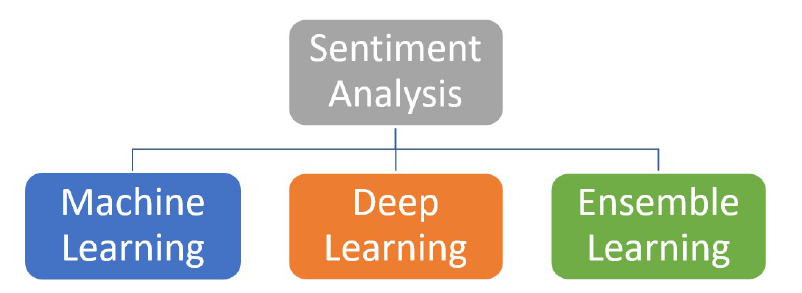
Figure 1. Sentiment analysis approaches can be categorized as machine learning, deep learning, or ensemble